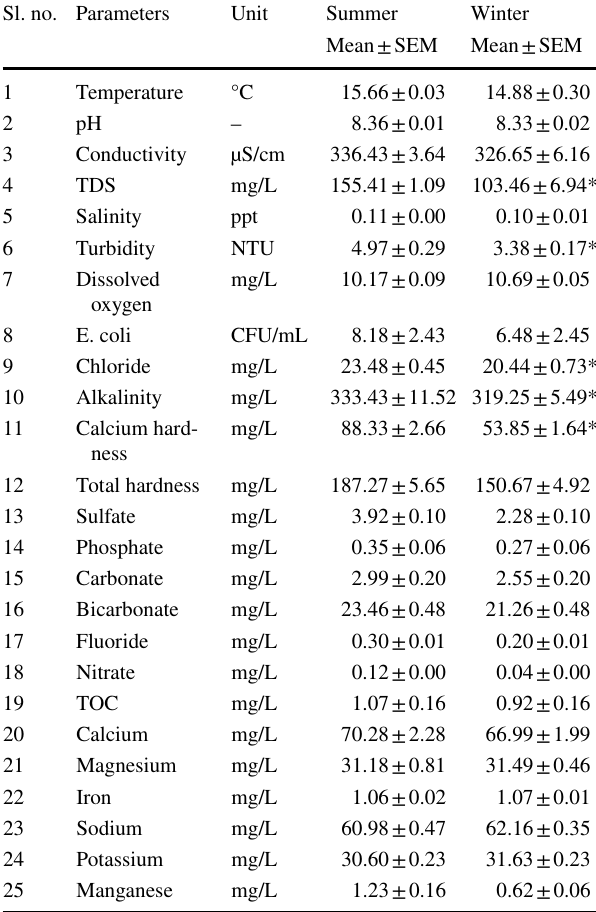
Table 6 Result after the execution of T test on the parameters of river water